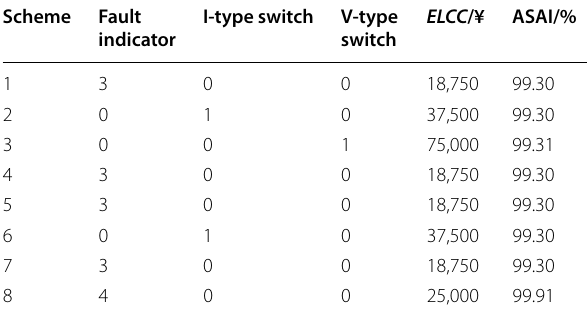
Table 5 Solution results when ASAI lim is 99.3%